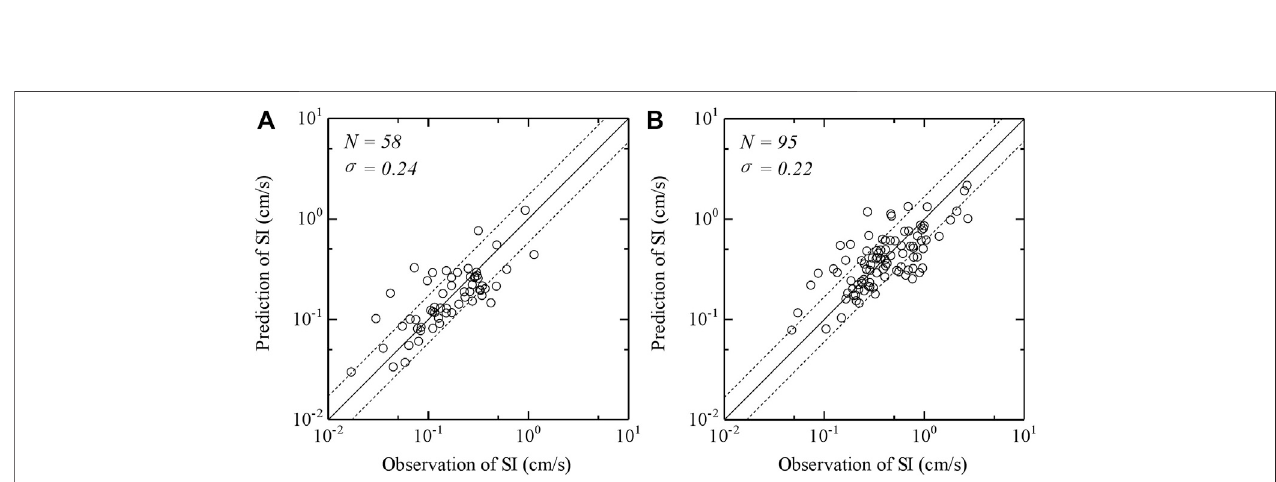
FIGURE 10 | Predicted SIs of S-wave for all the earthquakes at KS and SS stations against those observed. N and σ in the fi gures indicate the number of earthquakes and one logarithmic standard deviation, respectively. (A) KS station (B) SS station.